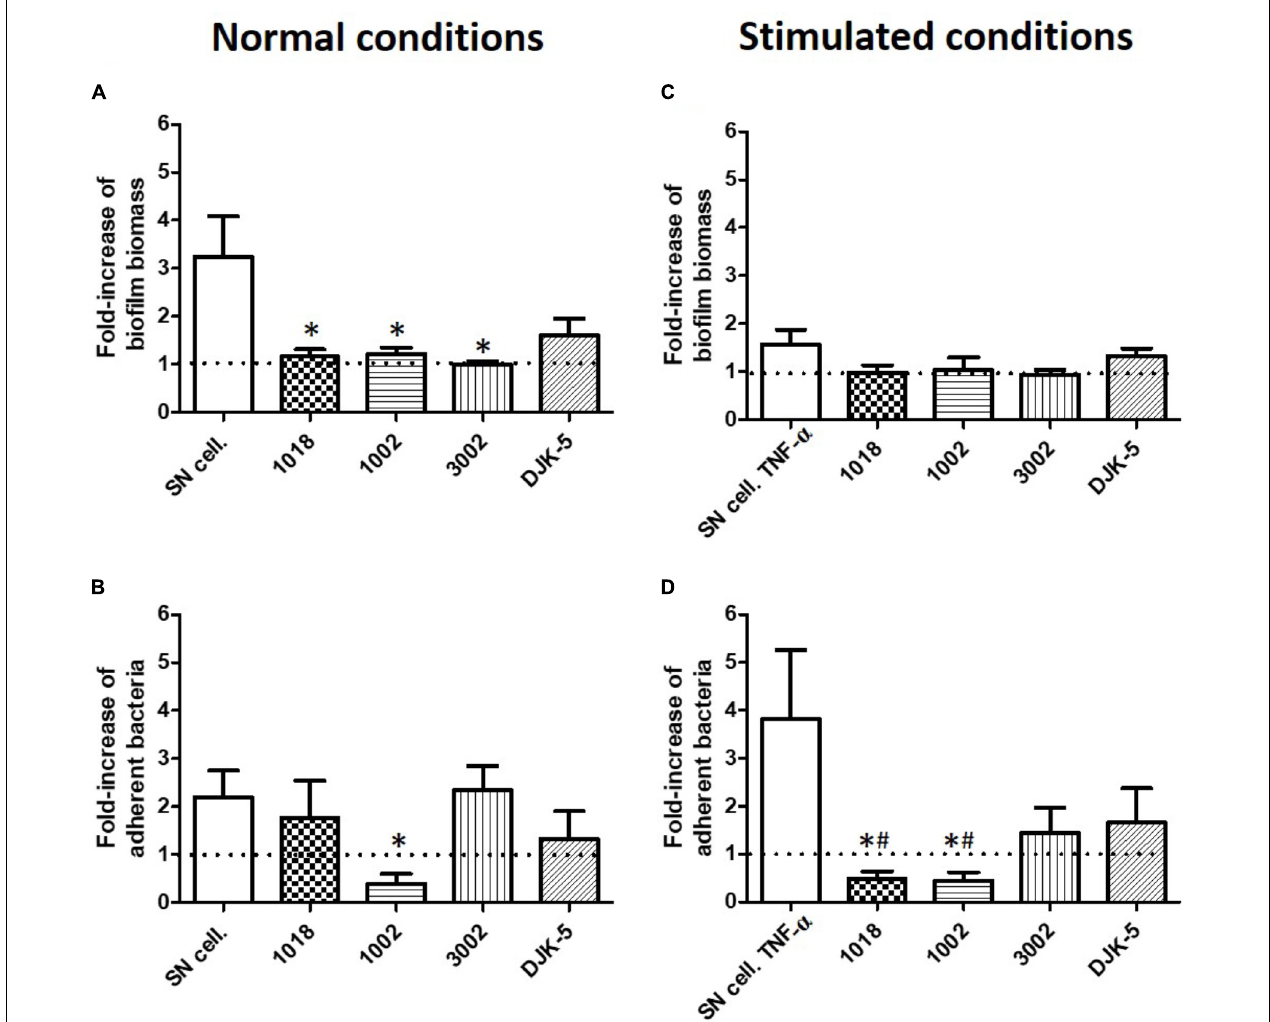
FIGURE 8 | Synthetic peptides (1018, 1002, 3002, and DJK-5, 5 µ g/ml) inhibited osteoblast products effect on S. aureus biofilm formation. Fold-increase of biofilm biomass quantified by crystal violet staining (A,C) and fold-increase of live adhered cells (B,D) under normal conditions of osteoblast-like culture (A,B) and TNF- α stimulated osteoblast-like culture (C,D) . SN cell., increase of biofilm formation in contact of osteoblast supernatants. SN cell. TNF- α , increase of biofilm formation in contact of osteoblast supernatants culture after TNF- α exposition. ( n = 9). ∗ Statistically significantly different from biofilm formed in the presence of SN cell or SN cell. TNF- α ( p < 0.05). #Statistically significantly different from basal level of biofilm formation. Dotted line = basal level of biofilm formed in the absence of SN cell or SN cell. TNF- α